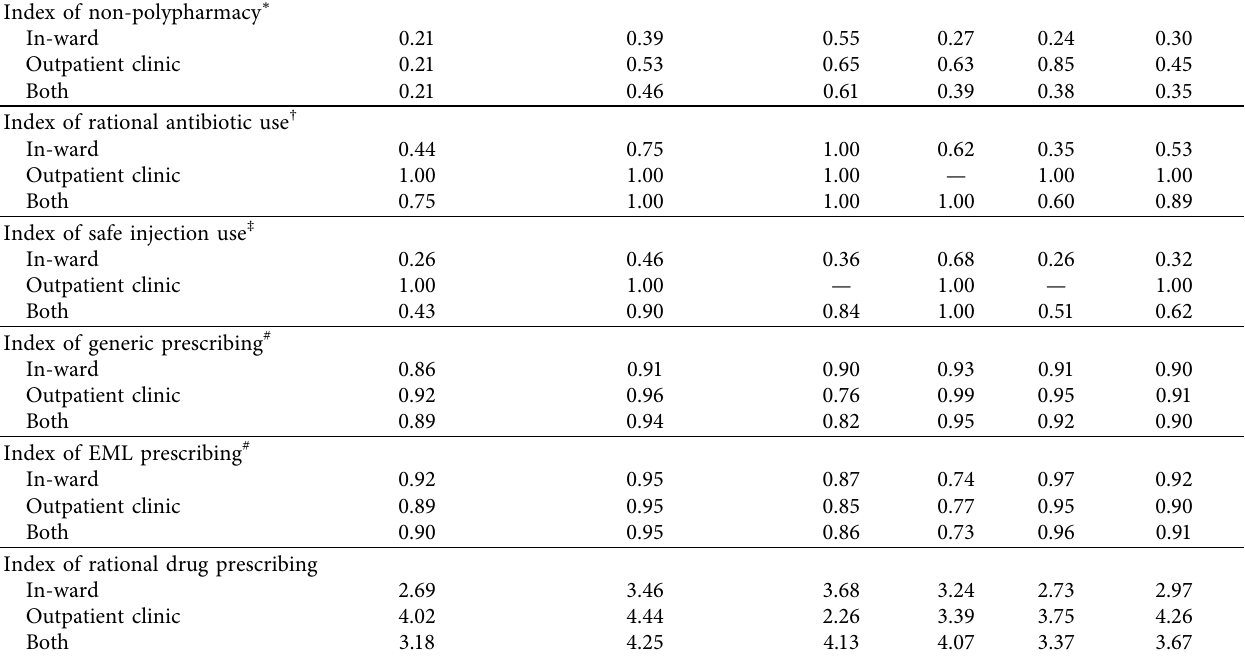
Table 3: Index of Rational Drug Prescribing